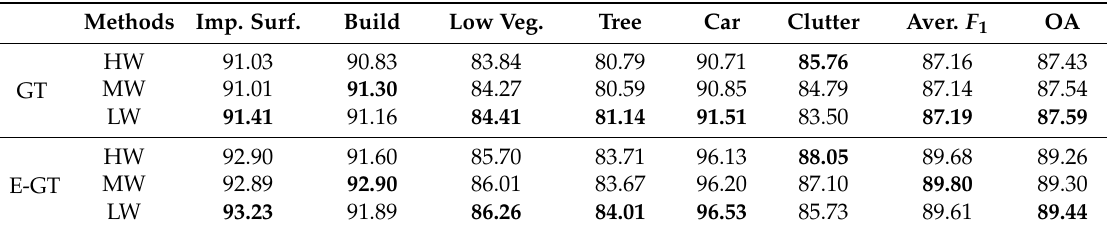
Table 4. Experimental results on the multi-scale extra branch (Potsdam validation set). HW is FSN with heavyweight branch; MW is FSN with middleweight branch; LW is FSN with lightweight branch (the proposed version); GT is Ground Truth; E-GT is Eroded Ground Truth. Methods Imp.